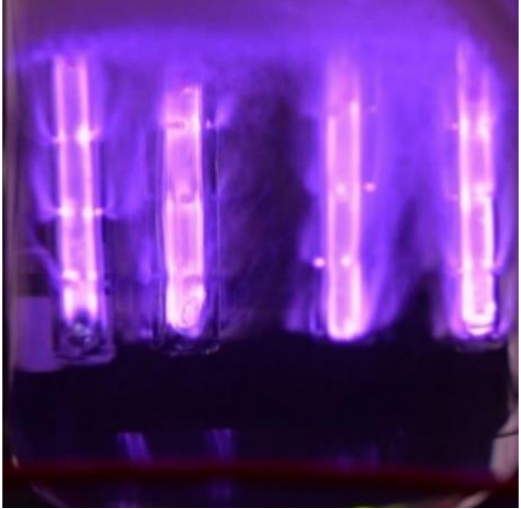
Figure 5. Four DBD devices discharge simultaneously under 20 kV high voltage drive (Pictures taken by Nikon D750, exposure time 10 ms).